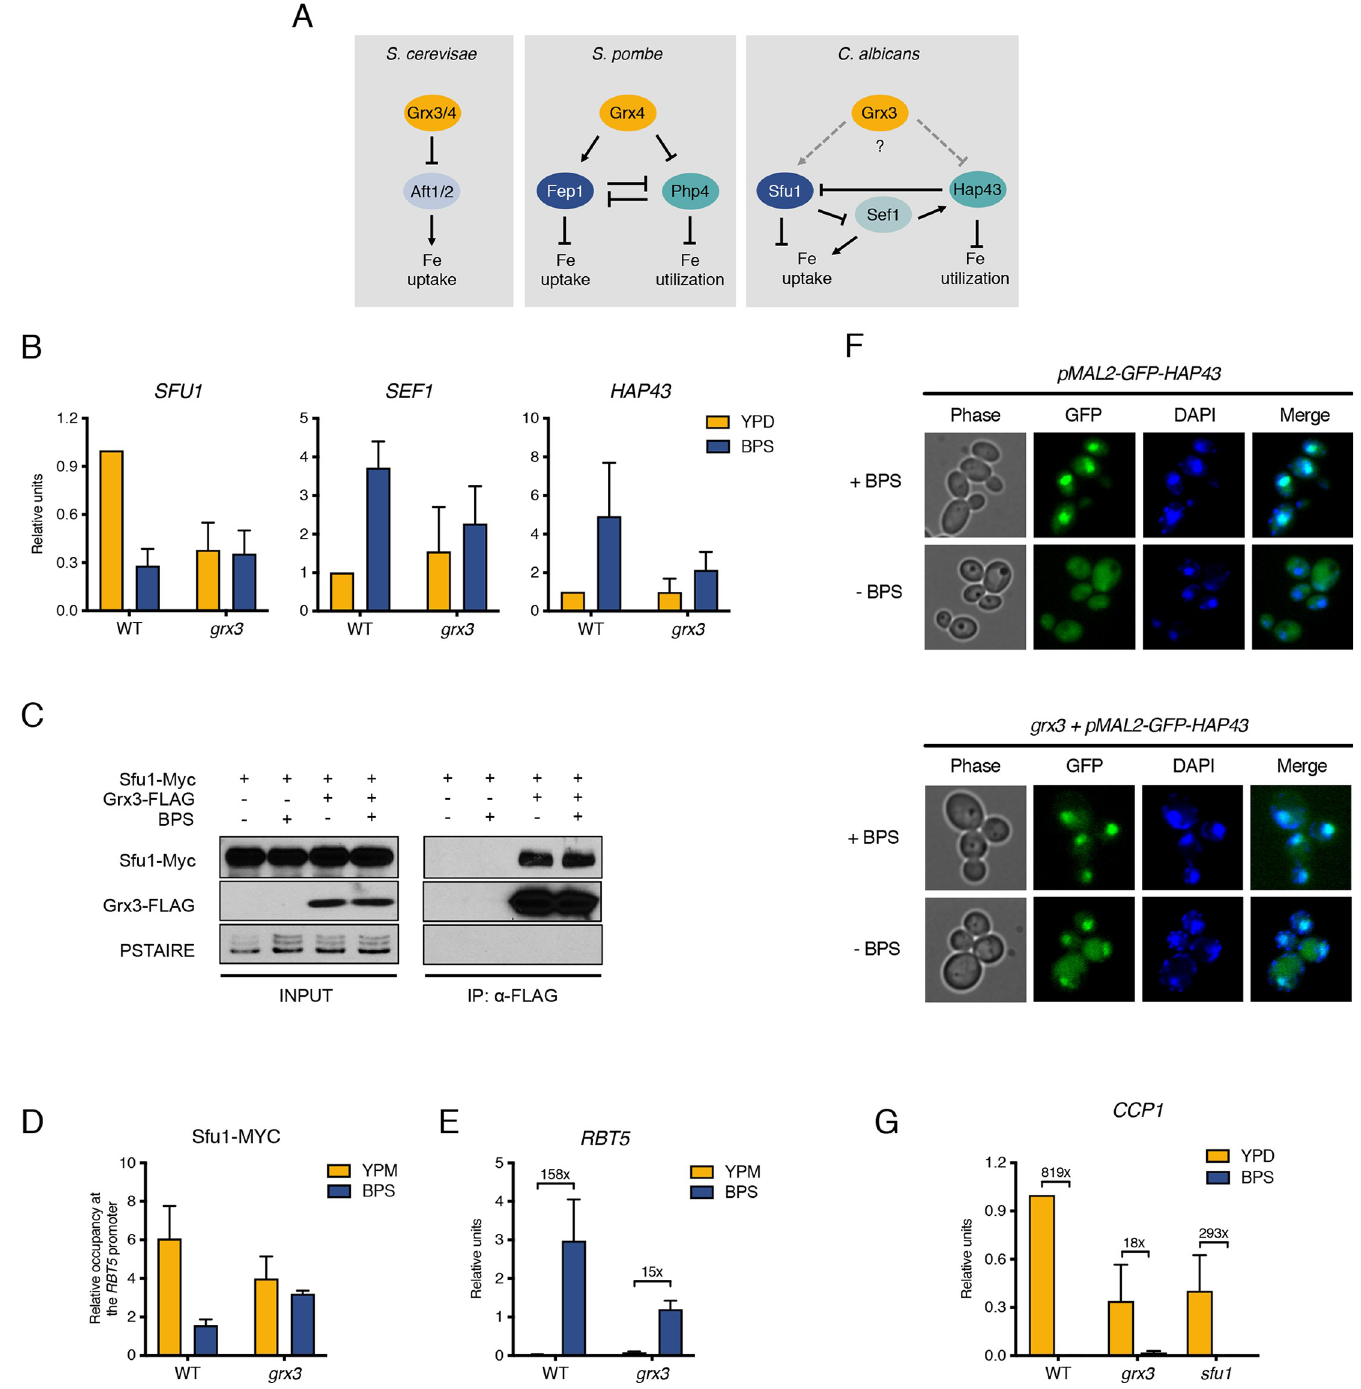
Fig 3. Grx3 regulates the iron homeostasis circuit in C . albicans . A. Current models of iron homeostasis regulation in S . cerevisiae , S . pombe , and C . albicans . B. Expression of SFU1 , SEF1 and HAP43 in WT (HLY4494) and grx3 mutant (HLY4492). Cells were grown in YPD media in the presence or absence of 500 μ M BPS. Expression level of the indicated genes was measured by qPCR and normalized to ACT1 . Presented is the average expression level from three independent experiments with error bars representing the s.d. The same applies to E , G . C. Immunopreicipitation of Grx3-FLAG. Strains HLY4500 ( pGRX3-GRX3-FLAG , pMAL2-SFU1-MYC ) and HLY4498 ( pMAL2-SFU1-MYC ) were grown in the presence or absence of 500 μ M BPS at 30˚C for 6hr. D. Chromatin immunoprecipitation of Sfu1-Myc. WT (HLY4498) and grx3 (HLY4507) strains carrying pMAL2-SFU1-MYC were cultured in the presence or absence of 500 μ M BPS at 30˚C. qPCR analysis of Sfu1 enrichment at the RBT5 promoter was calculated by the percent input method and is presented as a ratio of the RBT5 promoter relative to an ADE2 control region, with error bars representing SEM. E. RBT5 gene expression in WT (HLY4494) and grx3 (HLY4492) strains. F. Localization of MAL2 -driven GFP-Hap43 in hap43 (HLY4569) and grx3 (HLY45701). Cells were grown overnight in SCM in the presence or absence of 300 μ M BPS. G. CCP1 expression in WT (HLY4494), grx3 (HLY4492), and sfu1 . https://doi.org/10.1371/journal.pgen.1008881.g003 PLOS Genetics | https://doi.org/10.1371/journal.pgen.1008881 June 11,